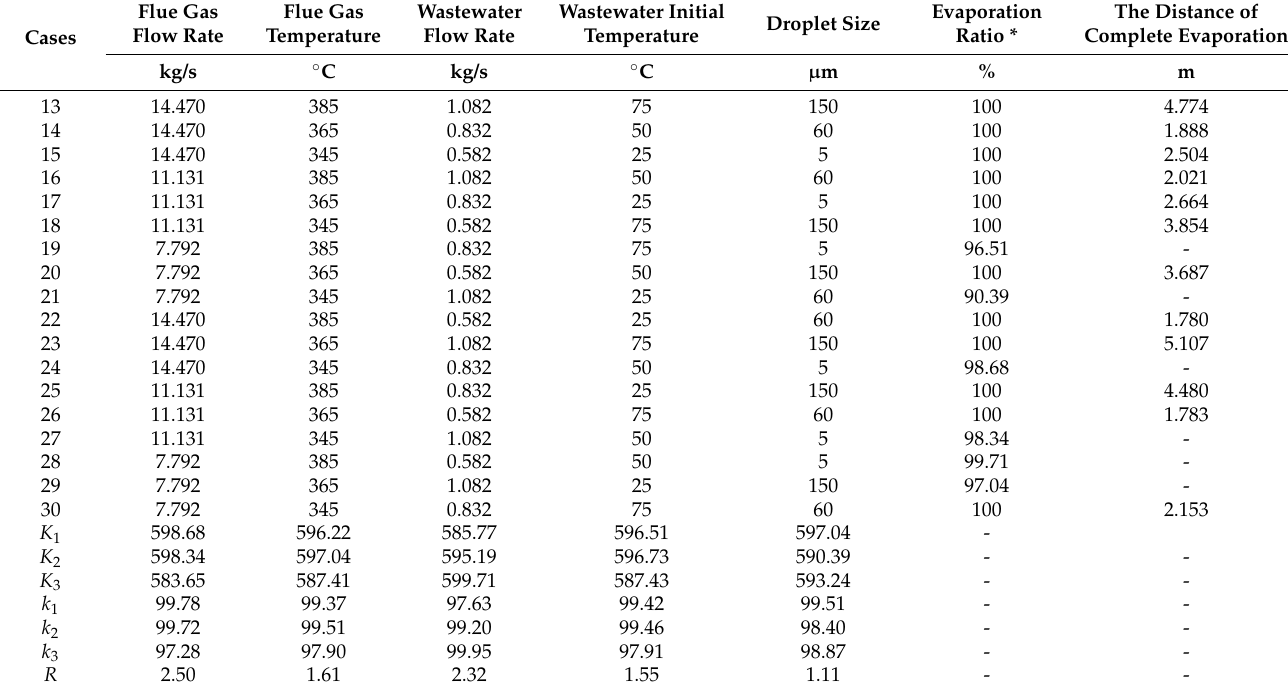
Figure 18. Effect of droplet sizes on evaporation performance. Table 4. Orthogonal table of each